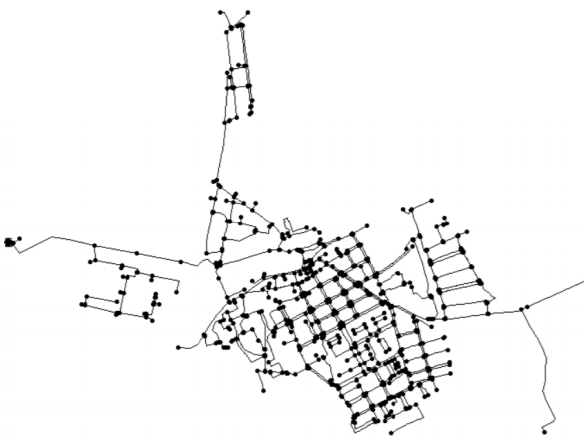
Figure 5: Water supply system’s